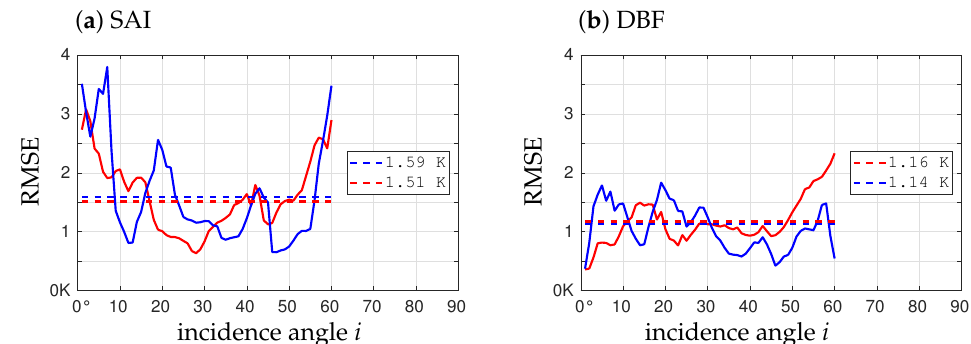
Figure 10. Variations of the RMSE in the floor error maps ∆ T H r (red) and ∆ T V r (blue) with the ground incidence angle i ( a ) for the SAI paradigm and ( b ) for the DBF one. Dashed lines indicate the level of the RMSE over the EAF-FOV taken from Table 1. Scaling is the same for both